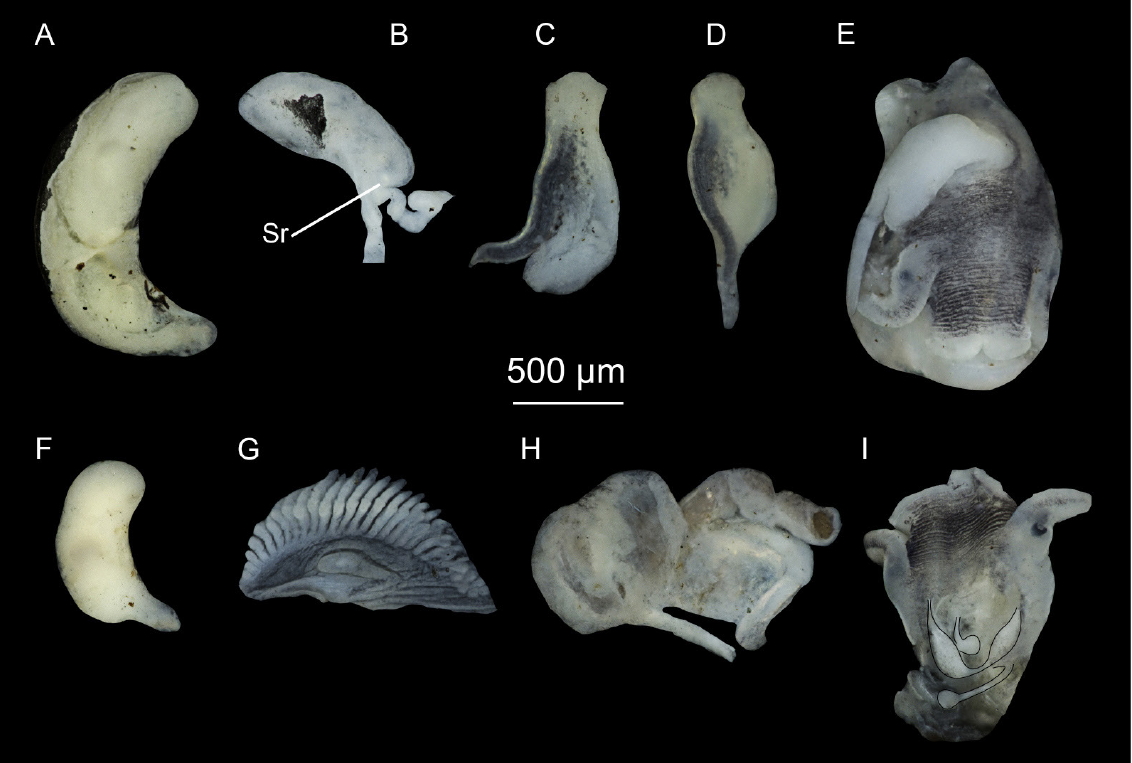
Fig. 28. Anatomy of Mercuria lupiaensis Miller & Delicado sp. nov. from Giammateo Creek, Frigole, Lecce. A–B . Female genitalia indicating the seminal receptacle (Sr). C–D . Penis. E . Head of a male. F . Prostate gland. G . Ctenidium and osphradium. H . Stomach. I . Head with perioesophageal ring